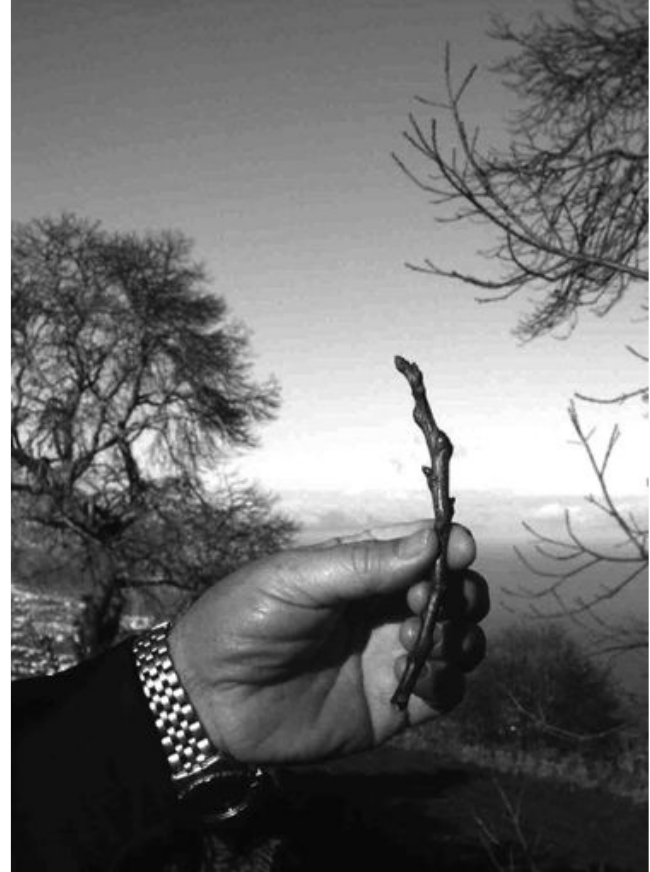
Fig. 5 - Scionwood for